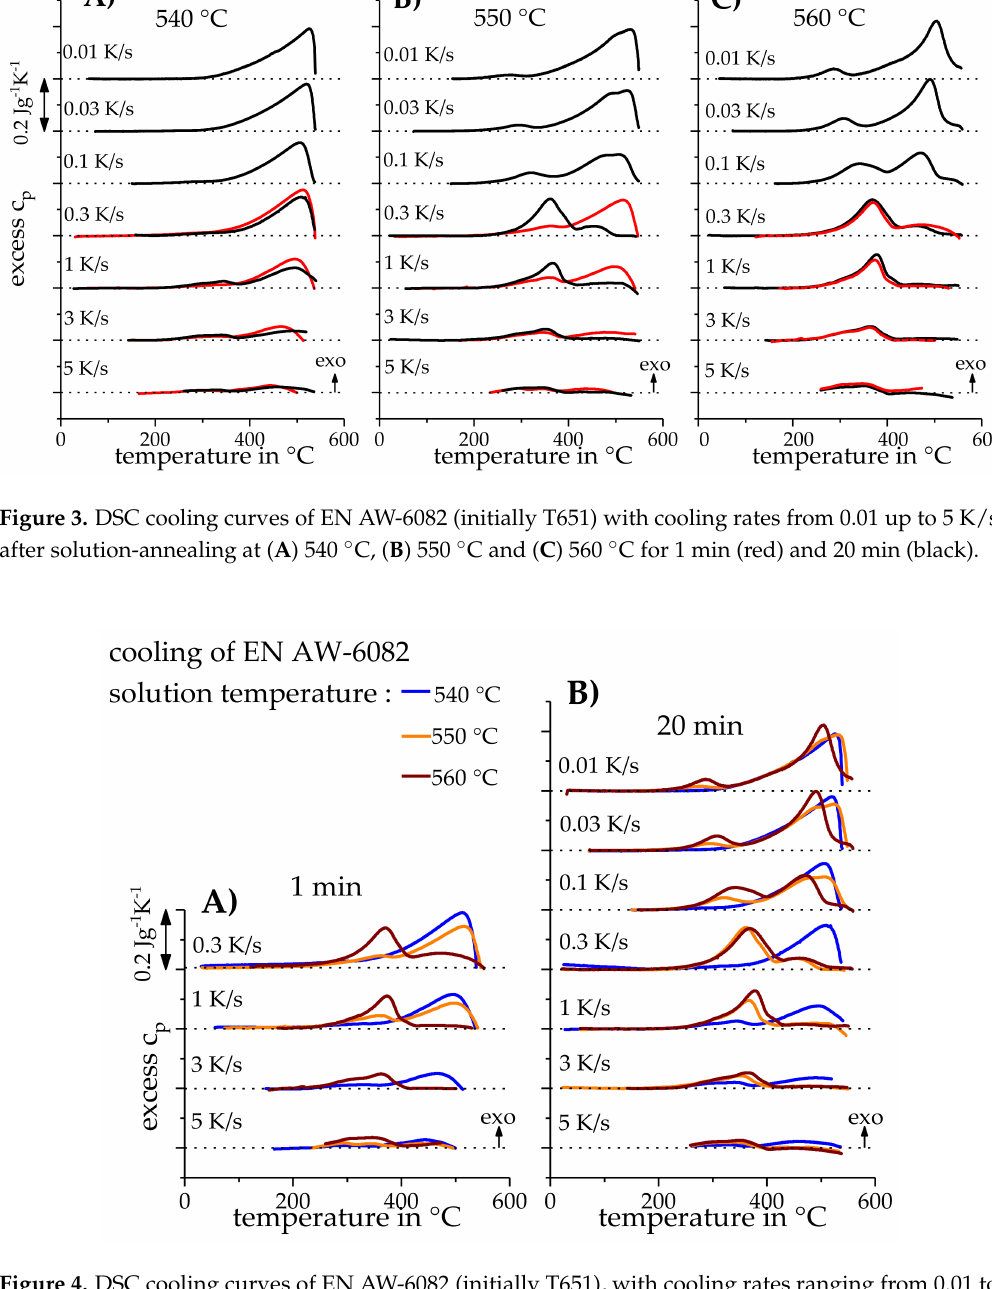
Figure 4. DSC cooling curves of EN AW-6082 (initially T651), with cooling rates ranging from 0.01 to 5 K/s and after solution-annealing at various conditions. ( A ) Soaking duration of 1 min and ( B ) 20 min. The three different applied temperatures are color-coded to highlight the degree of variability with soaking time and cooling